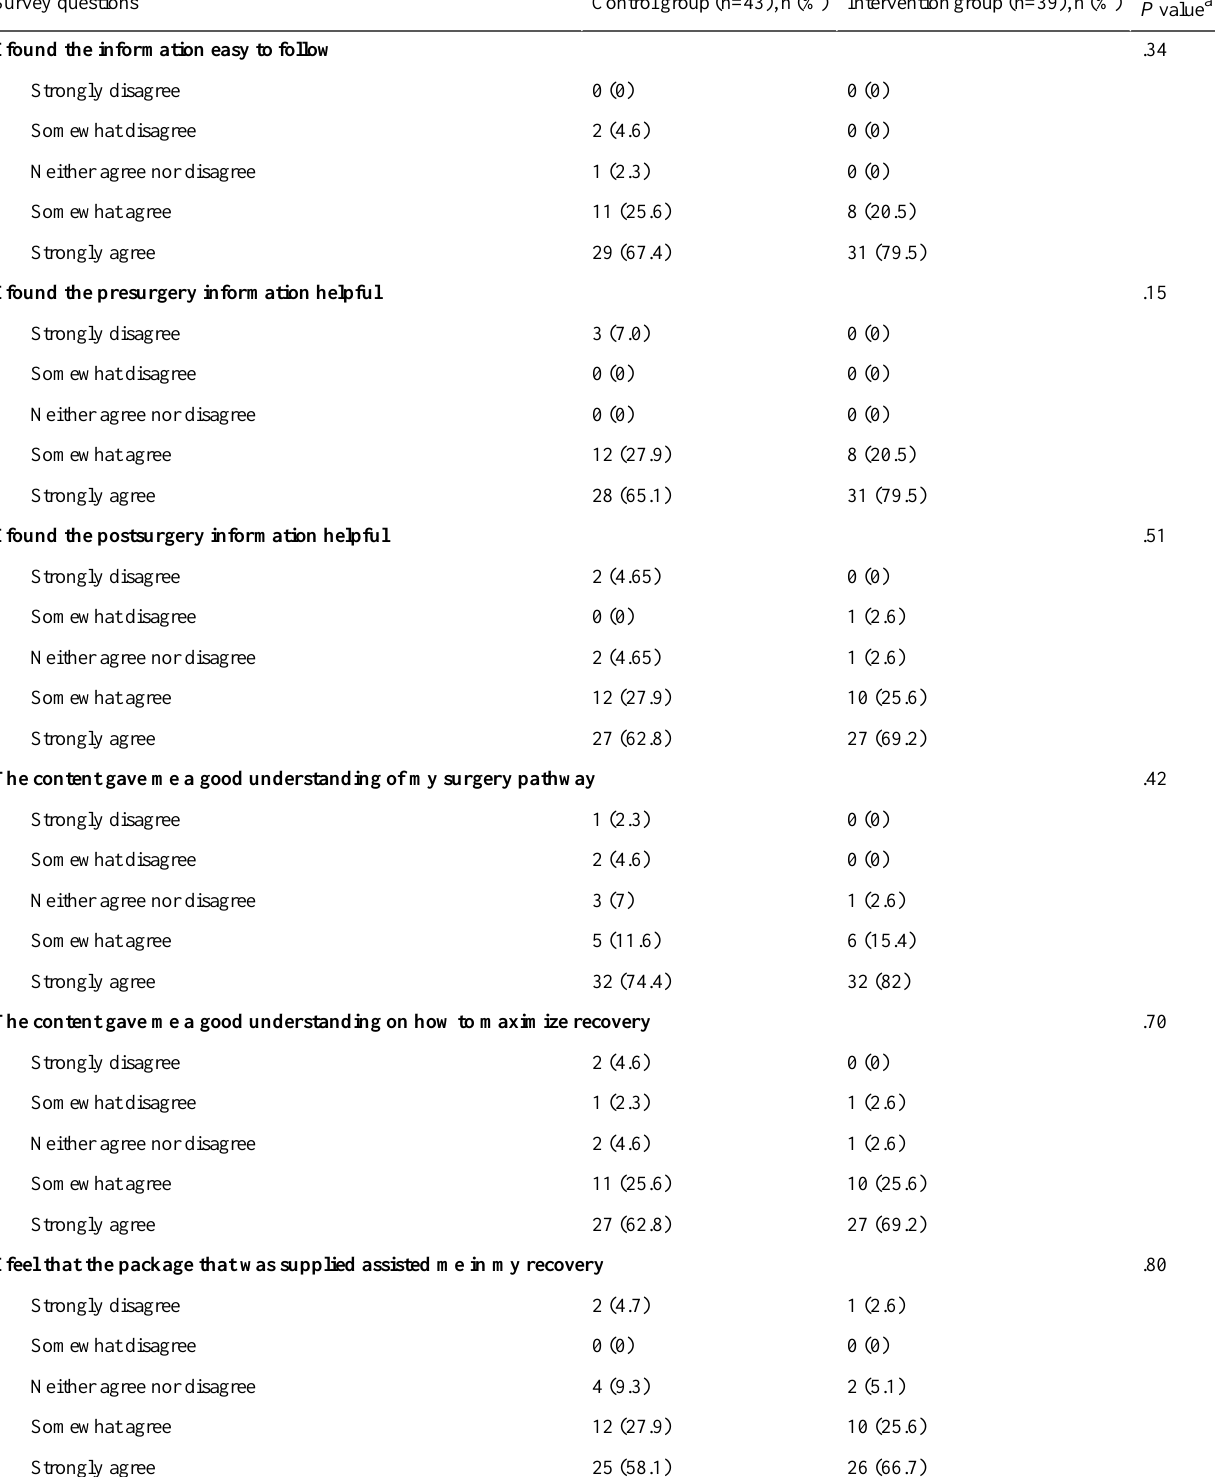
Table 5. Satisfaction survey results by